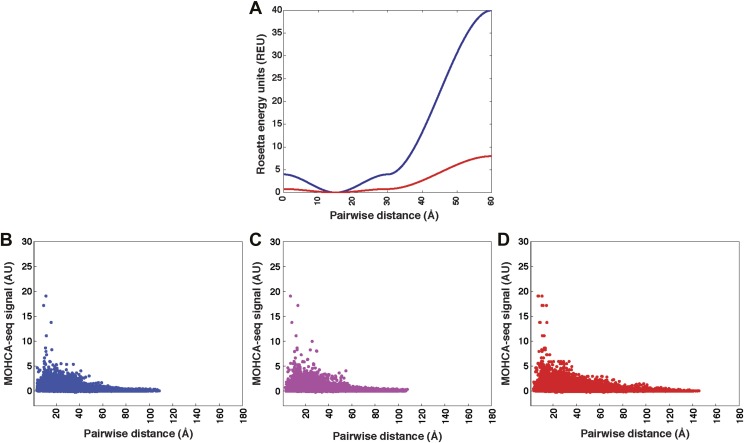
Pseudo-energy potential used to incorporate MOHCA-seq constraints in Rosetta modeling, and plots of MOHCA-seq signal vs pairwise distance.(A) Pseudo-energy potentials for strong (blue) and weak (red) MOHCA-seq constraints. The potential was generated using the smoothstep function (see ‘Materials and methods’). (B) MOHCA-seq signal vs pairwise distance plot for crystal structures of RNAs listed in Table 1. (C) MOHCA-seq signal vs pairwise distance plot for MCM models of RNAs listed in Table 1 and HoxA9 IRES domain. (D) MOHCA-seq signal vs pairwise distance plot for ligand-free MCM models of c-di-GMP, glycine, and AdoCbl riboswitch aptamers shown in Figures 4C, 5C, 6B. Pairwise distances are calculated between 2′-OH of first residue (‘radical source location’) and C4′ of second residue (‘cleavage location’). MOHCA-seq signal is from final COHCOA data sets and ignores pairs of residues separated by fewer than 7 nucleotides due to ambiguities in aligning short reads to the RNA sequence.